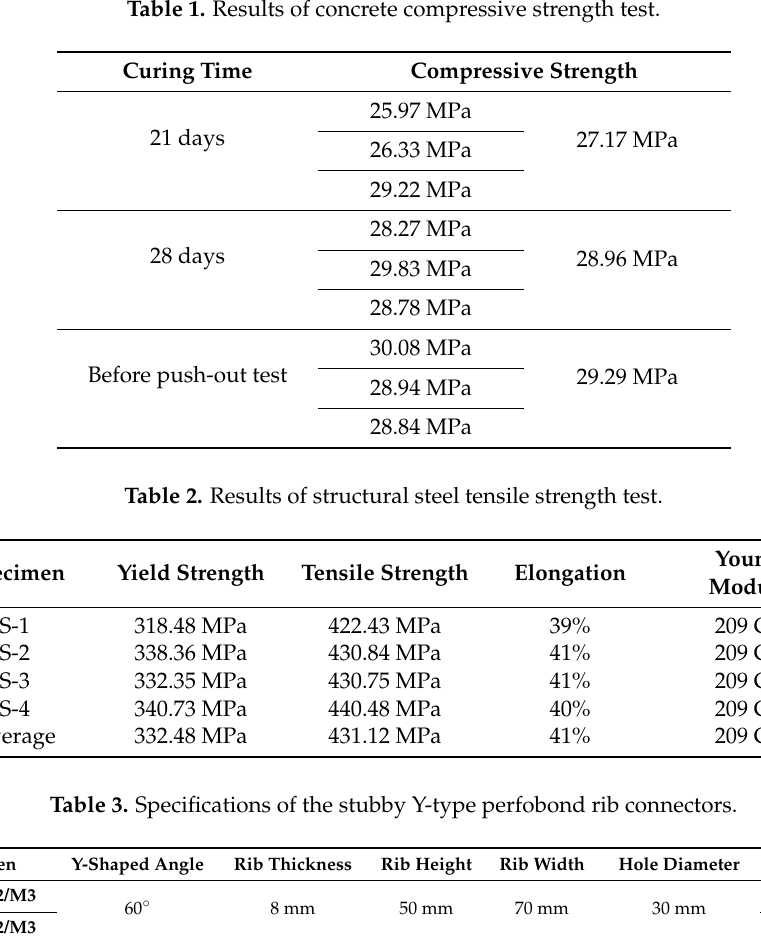
Table 1. Results of concrete compressive strength test.